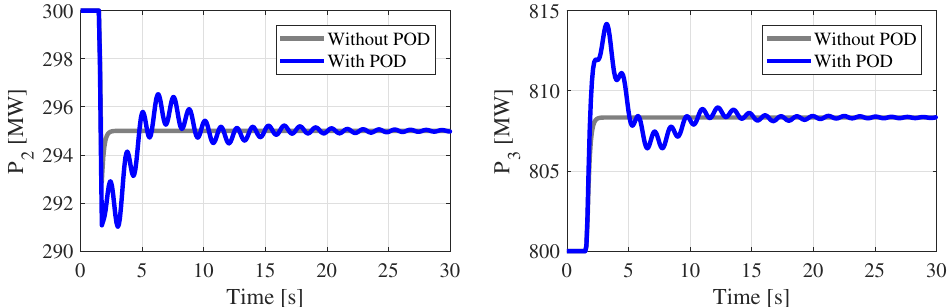
Figure 11. Power fed from VSC2, P 2 , and generated power by the OWF, P 3 , when using AFC (Case C) in parallel with a POD control.